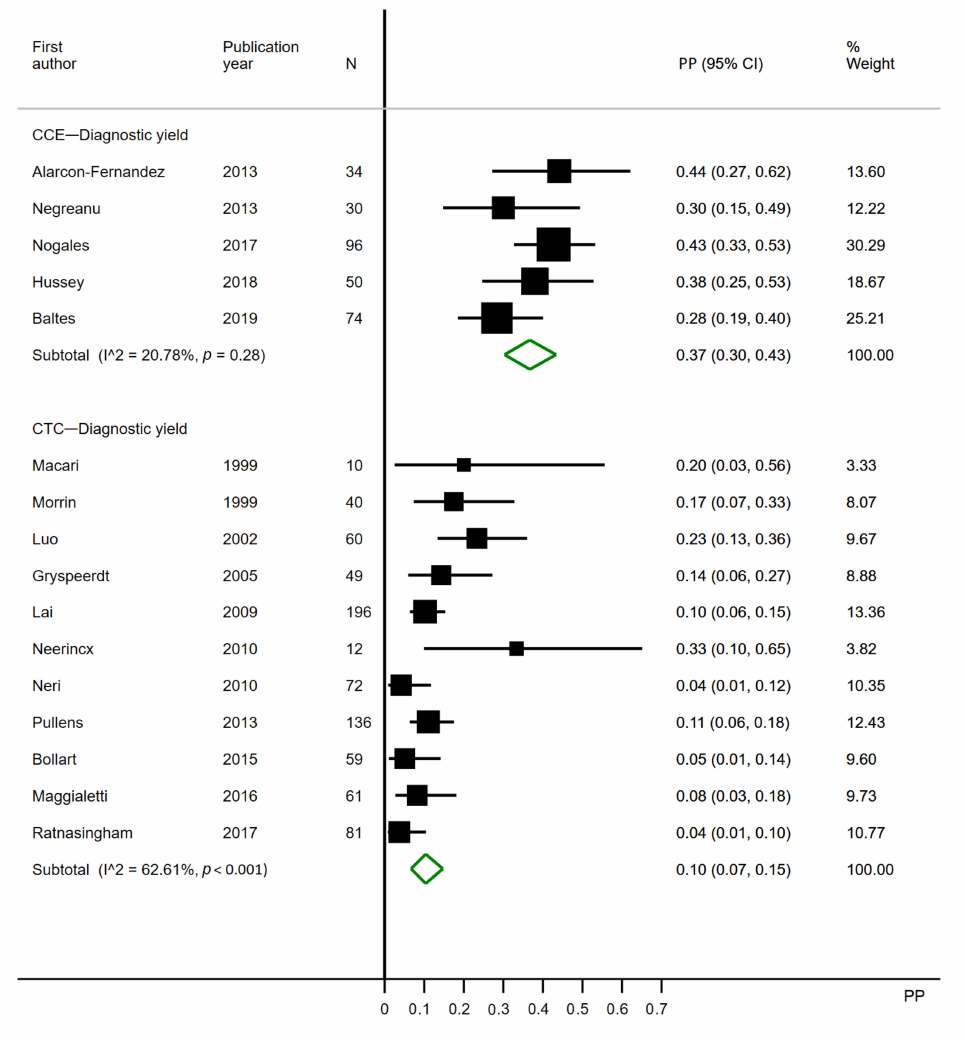
Figure 3. Forest plot of the per patient diagnostic yields for polyps of any size in colon capsule endoscopy and in CT colonography following incomplete colonoscopy. PP: estimated prevalence